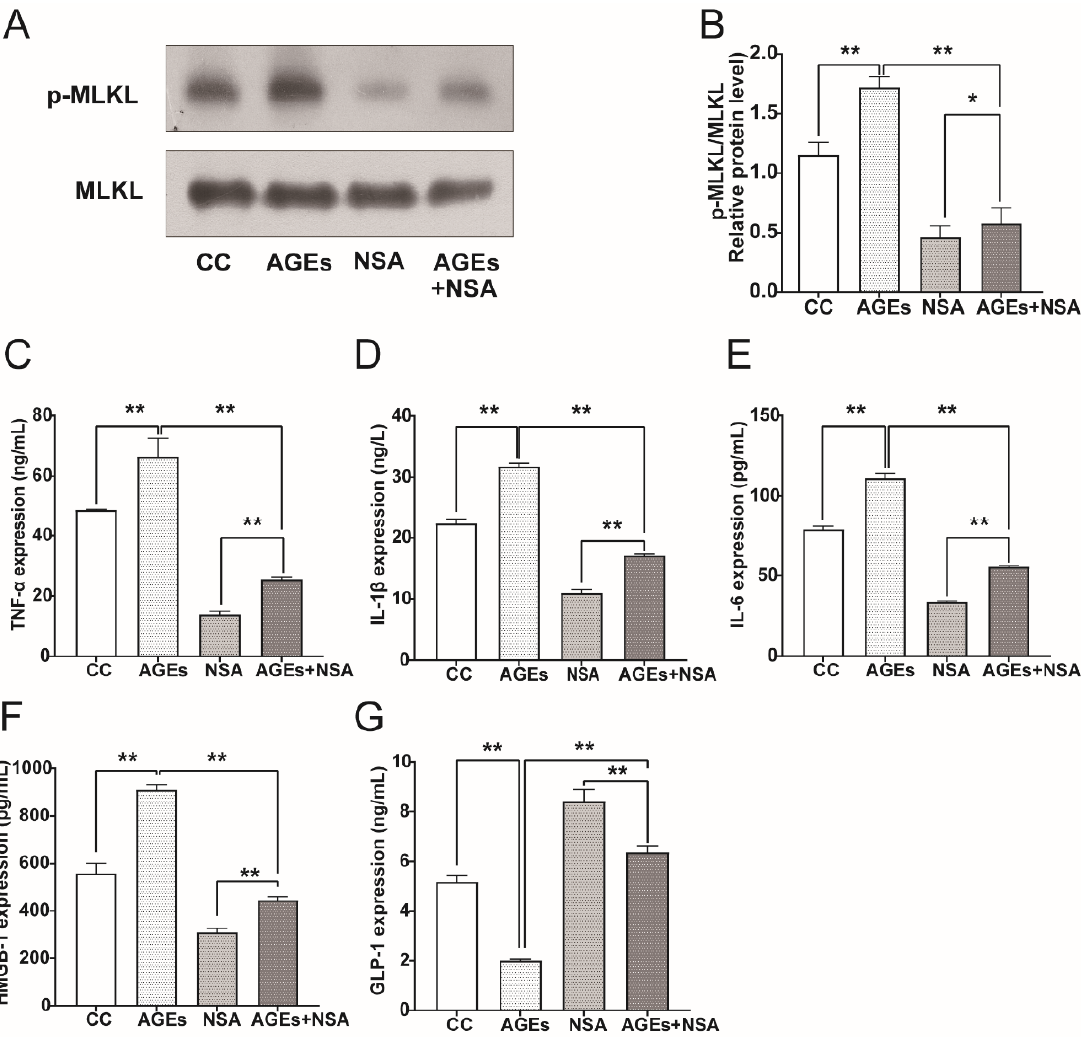
Figure 8. NSA partially reversed AGEs-induced phosphorylation of MLKL and upregulation of pro- inflammatory cytokines. ( A ) Western blot showing p-MLKL protein level in STC-1 cells in presence of AGEs with or without MLKL inhibitor NSA. ( B ) The histograms represent the means of three experiments ± SD. ( C – G ) ELISA assay revealing HMGB1, TNF- α , IL-1 β , IL-6, and GLP-1 release in STC-1 cells in presence of AGEs with or without NSA. Data were expressed as the means ± SD from three independent experiments. * p < 0.05, ** p < 0.01. NSA: necrosulfonamide.